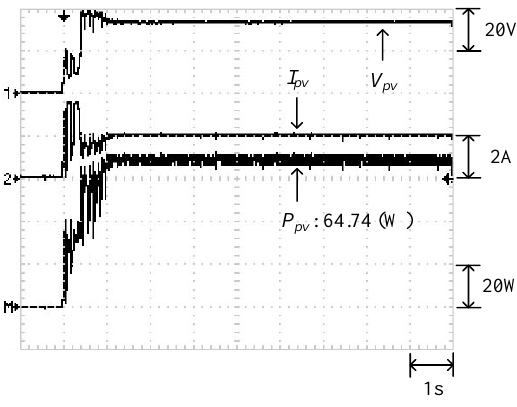
Figure 19. Maximum power point of Case 4 determined through the conventional PSO algorithm.